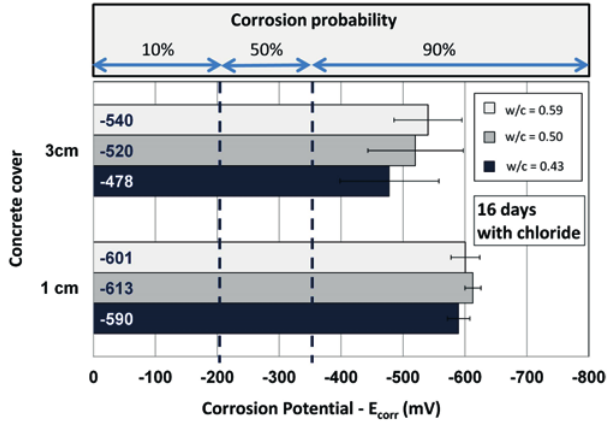
Influence of cover on corrosion potential with w/c= 0.43; 0.50 and 0.59 – without